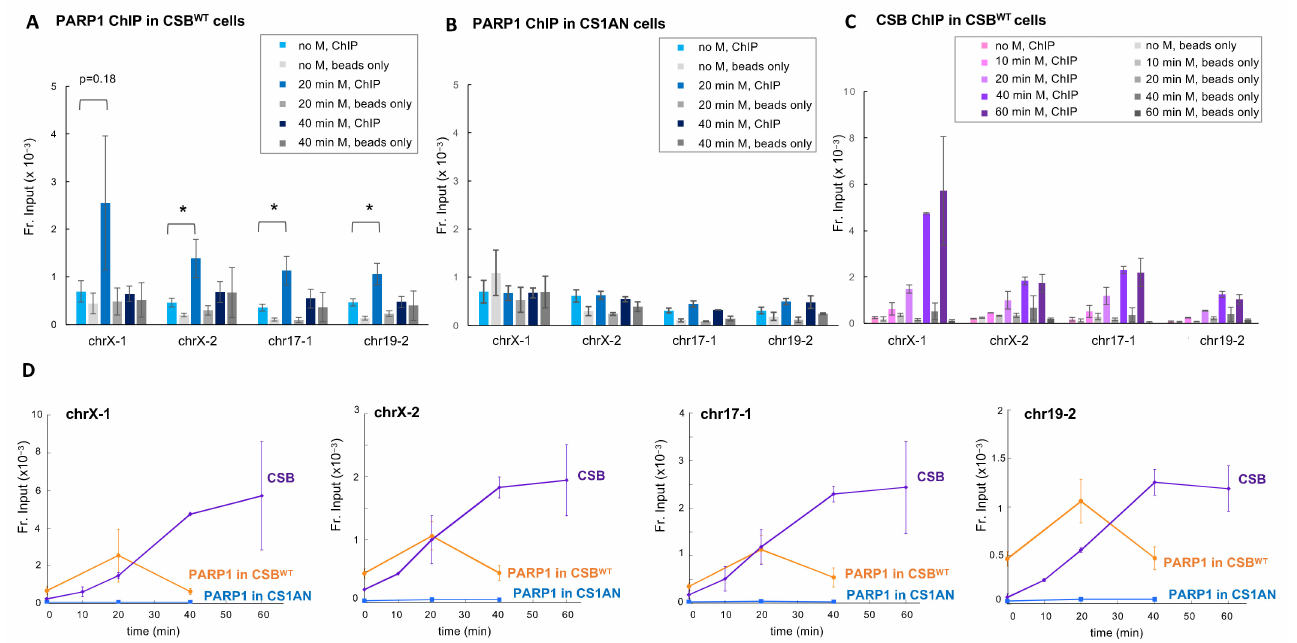
Figure 2. Transient PARP1 recruitment to menadione-induced CSB binding sites is CSB dependent. ( A ) PARP1 ChIP-qPCR in CSB WT cells and ( B ) CS1AN cells at different time points during 100 µ M menadione treatment. Paired t -tests were used to compare PARP1 enrichment at 20 min of menadione treatment to no treatment; *: p < 0.05. No significant PARP1 enrichment over “beads-only” control at 40 min of treatment in CSB WT cells. No significant PARP1 enrichment over “beads-only” control at all time points in CS1AN cells. ( C ) CSB ChIP-qPCR in CSB WT cells. ( D ) Graphical overlay of